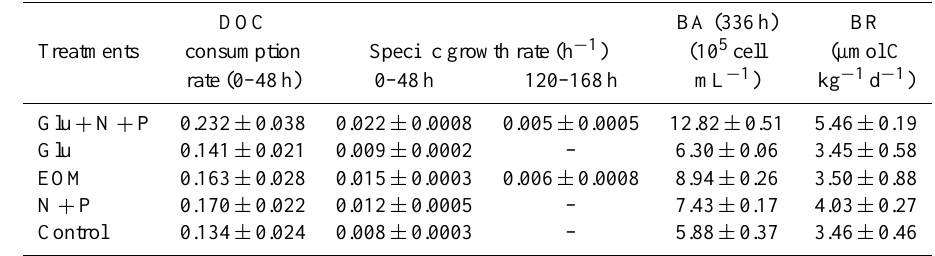
Table 2. The DOC consumption rate, bacterial community specific growth rate, bacterial abundance (BA) and bacterial respiration rate (BR) in the incubation